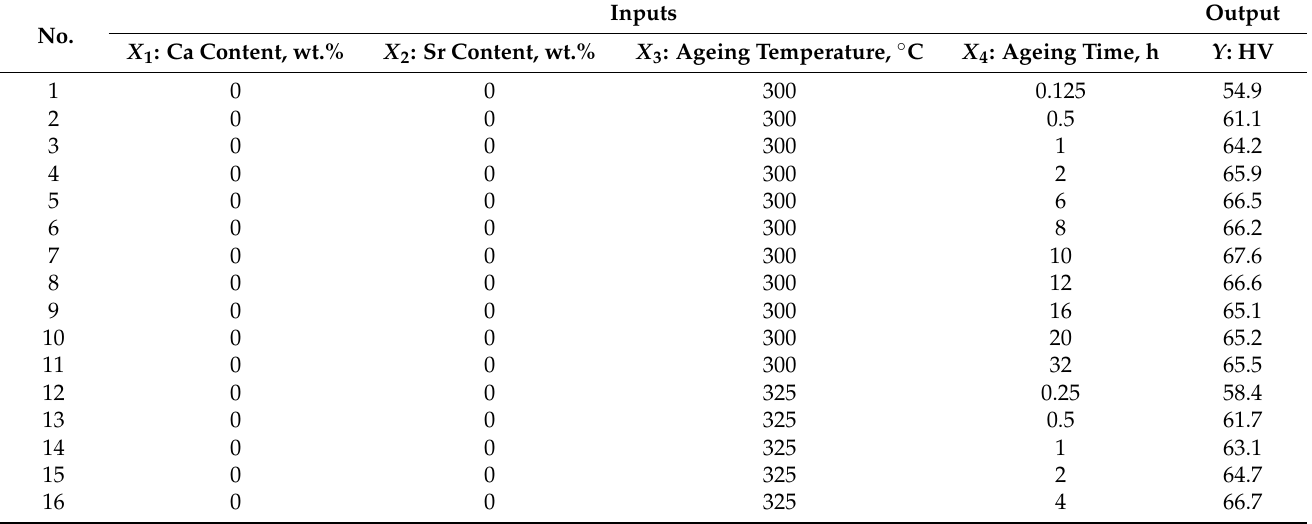
Table A1. The experimental